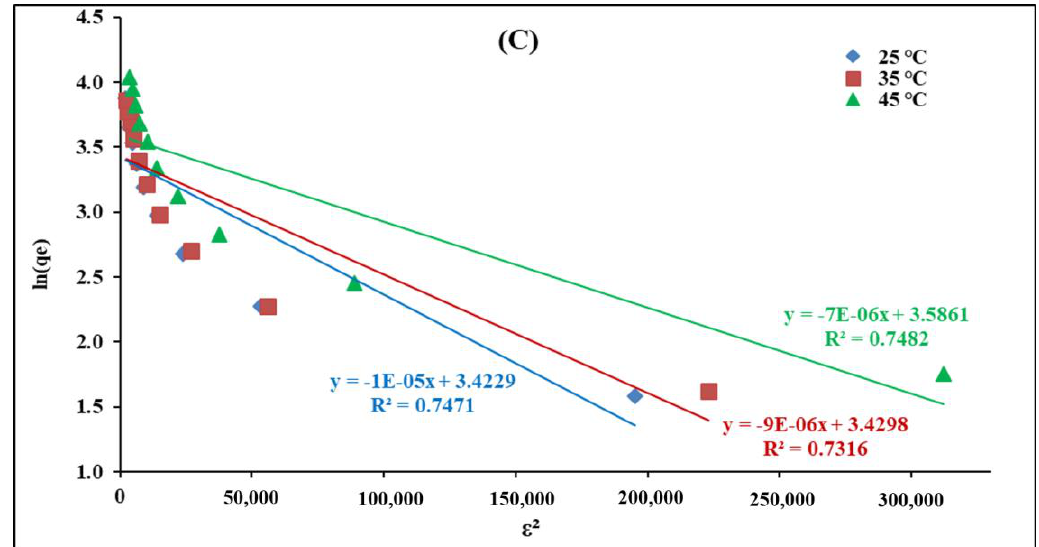
Figure 12. Linear adsorption ( A ) Langmuir(II) isotherm, ( B ) Freundlich isotherm, and ( C ) D-R isotherm of U(VI), at pH 3.0 at 25.0, 35.0, and 45.0 °C.